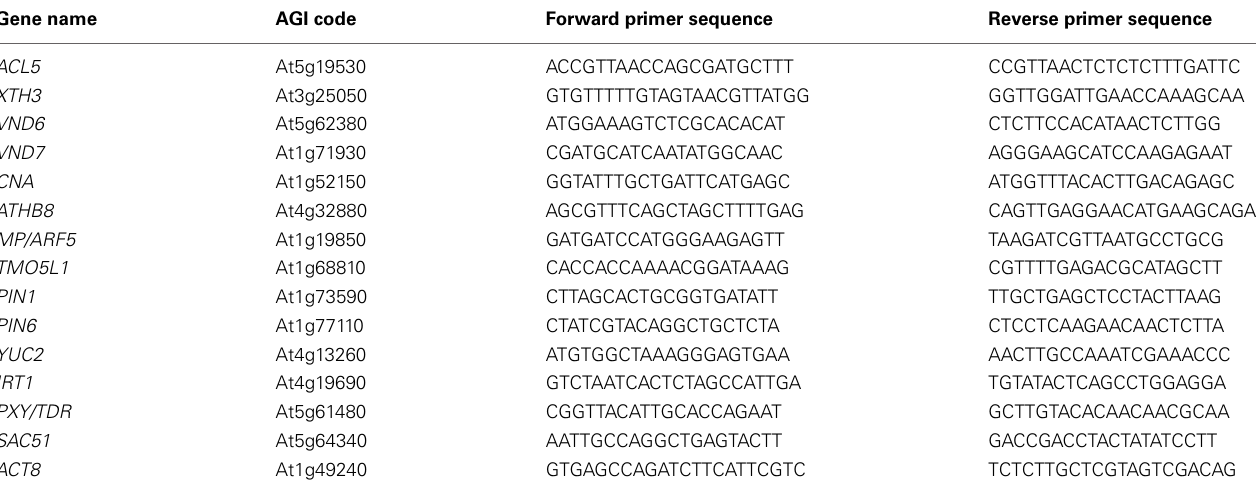
Table 2 | Primer sequences of the genes used for RT-PCR